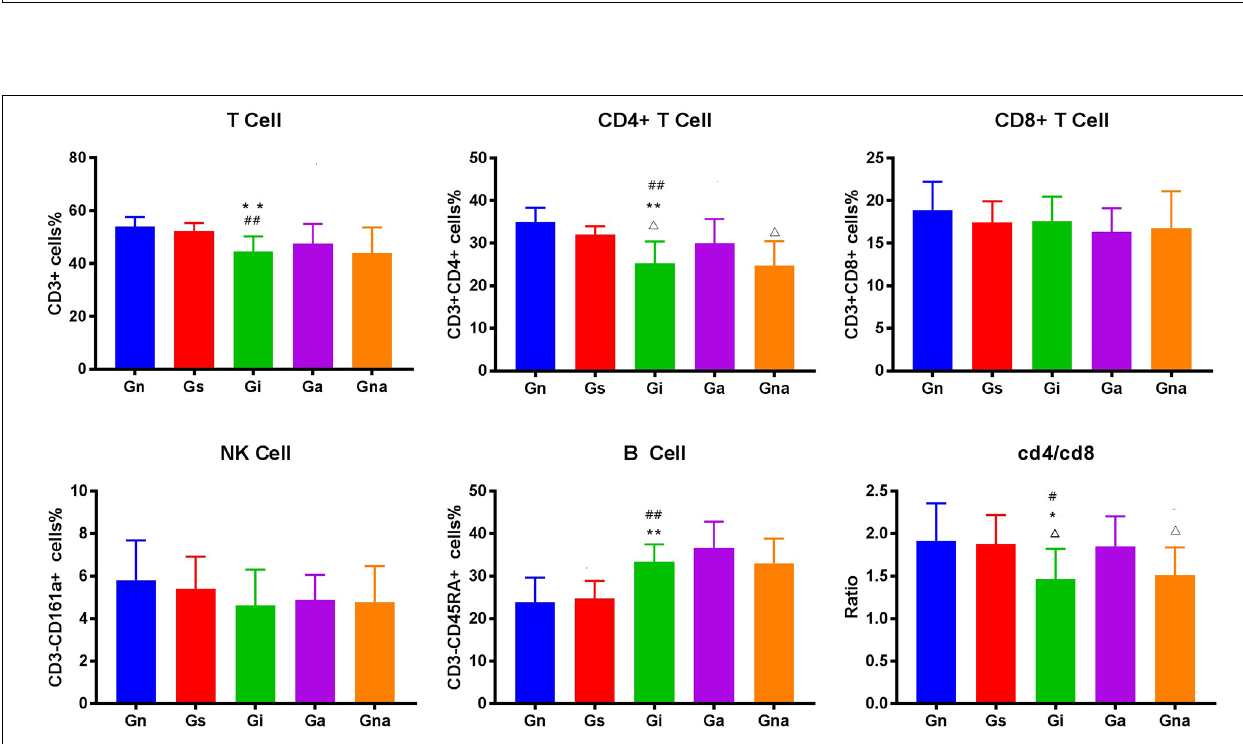
FIGURE 5 | Effect of acupuncture on splenic lymphocyte subsets. The data are expressed as the mean ± SEM ( n = 10). * P < 0.05, ** P < 0.01, vs. Gn group; # P < 0.05, ## P < 0.01, vs. Gs group; (cid:77) P < 0.05, (cid:77)(cid:77) P < 0.01, vs. Ga group. Gn, normal group; Gs, sham-operated group; Gi, impaired group; Ga, acupoint group; Gna, non-acupoint